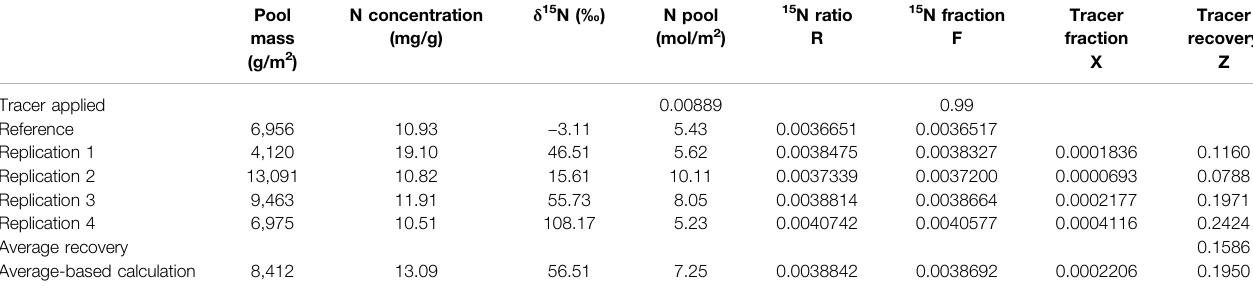
TABLE 2 | Calculation of tracer recovery by averaging the recovery of single samples (replications) vs. the calculation based on average N concentrations and δ 15 N. Pool mass (g/m 2